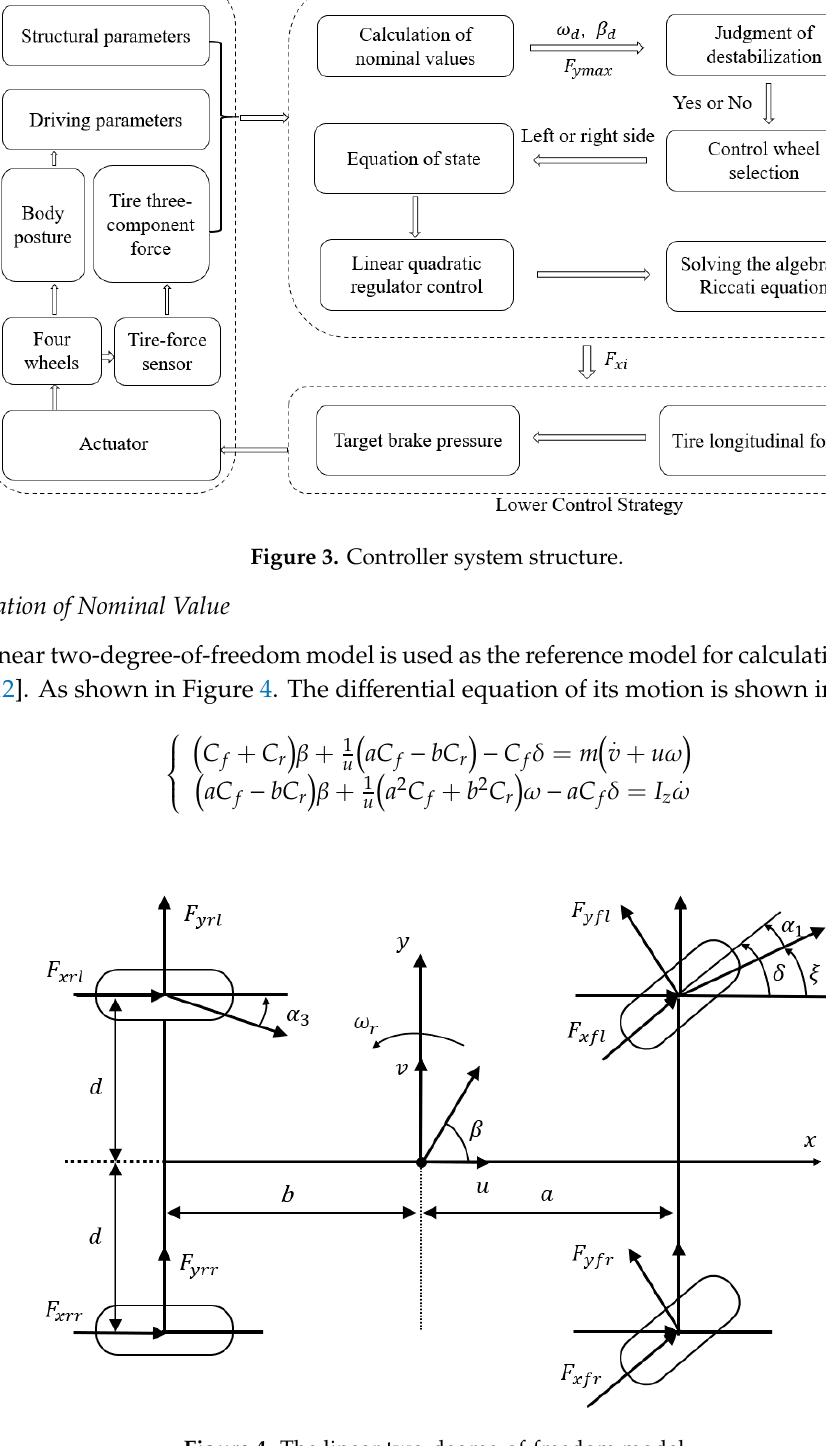
Figure 4. The linear two-degree-of-freedom model.